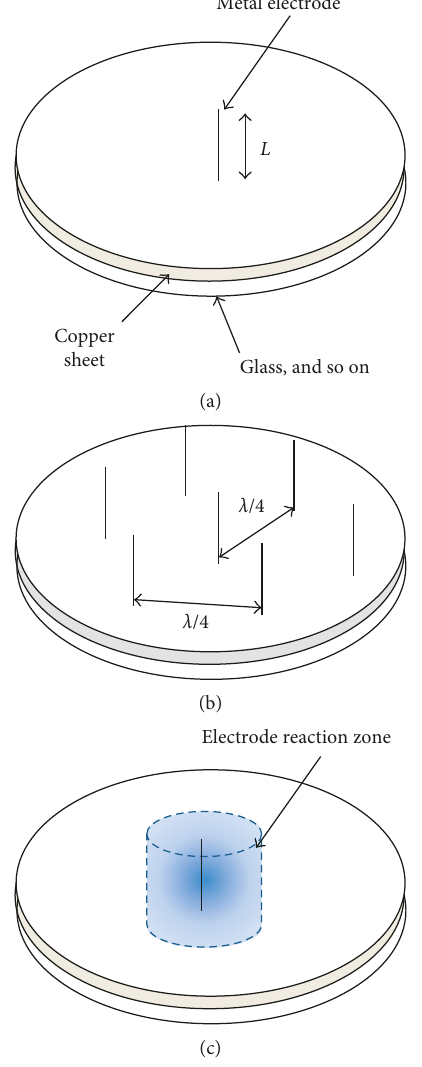
Figure 3: Typical single-tip electrode arrangement (a); multiple electrode arrangements (b); electrode reaction zone